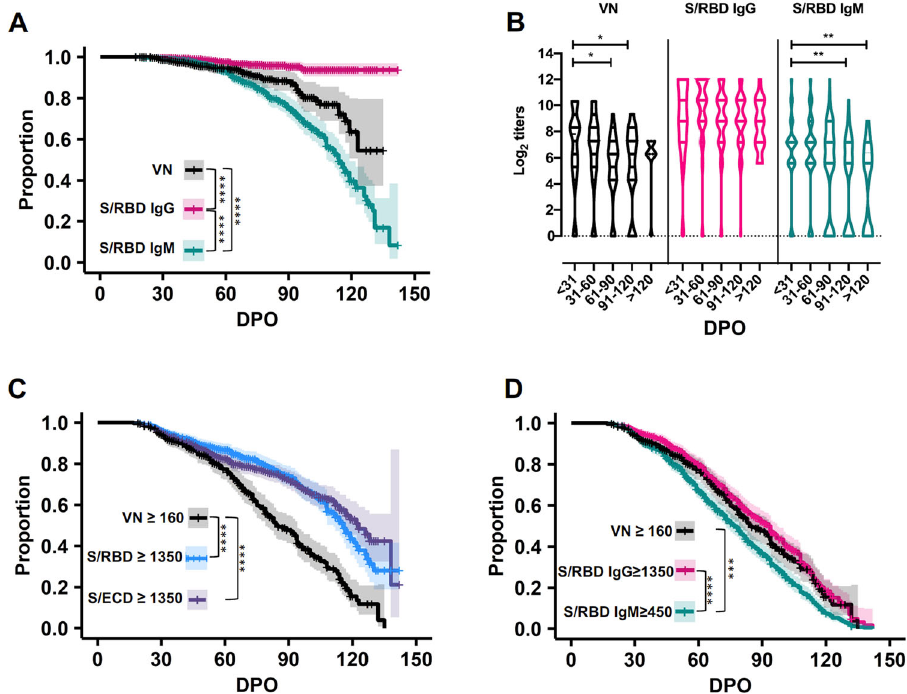
Fig. 2 Survival analysis of IgG, IgM, and VN antibody titers to SARS-CoV-2 spike-receptor binding domain (S/RBD). These data represent IgG and IgM antibody titers to SARS-CoV-2 spike-receptor binding domain (S/RBD) in 540 samples and virus neutralizing antibody (VN) titers in 305 samples collected from convalescent individuals ( n = 175) during the fi rst 140 days post onset of symptoms (DPO). A Proportion of S/RBD IgG seropositive convalescent individuals remained high through 140 DPO, while IgM seropositivity remained high through the fi rst 60 DPO and then steadily declined over the next 60 days (log-rank test; **** P < 0.0001). The proportion of individuals with VN responses also began to decline 60 DPO, with ~50% of individuals remaining seropositive with VN test through 140 DPO (log-rank test; *** P < 0.001). B Violin plots showing a signi fi cant decline in VN and IgM titers with time (ordinary one-way ANOVA, Tukey ’ s multiple comparison test; * P < 0.05; ** P < 0.01); the IgG titers remained stable until after 120 DPO. Comparison of proportion of individuals seropositive with S/RBD, S/ECD, and S/RBD IgG titers ≥ 1350 as well as with S/RBD IgM titer ≥ 450 to the proportion of individuals possessing VN titers ≥ 160 through 140 DPO are depicted in C , D , respectively (*** P < 0.001; **** P <